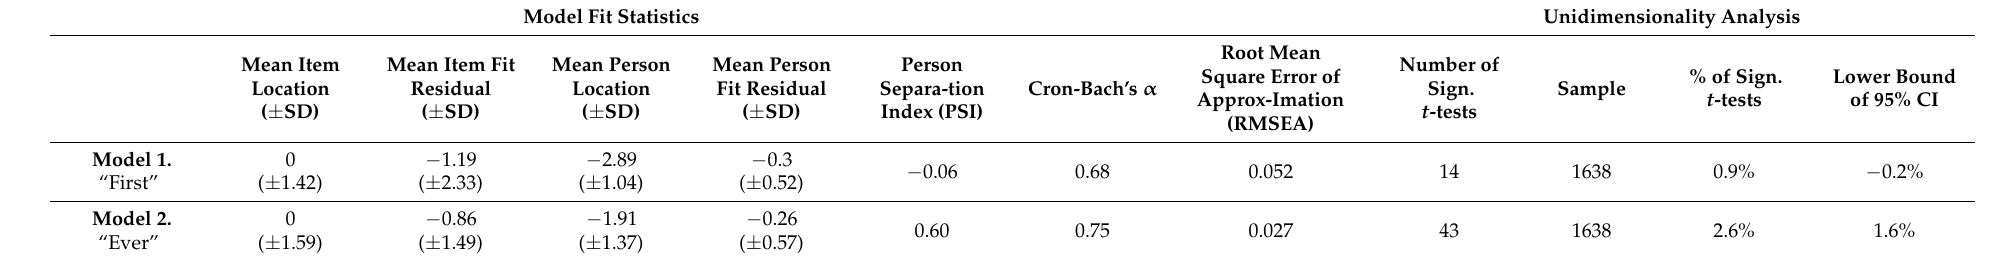
Table 2. Model fit statistics. Mean item log residual test of fit, item–trait interaction chi-square statistics, and Root Mean Square Error of Approximation (RMSEA) were calculated to assess model fit. Model 1 (“First”) refers to the questionnaires filled in for the first time when the participants entered the study. In Model 2 (“Ever”), a symptom was considered affirmed by a participant if it was ticked at least once during the period of nationwide restrictive measures.